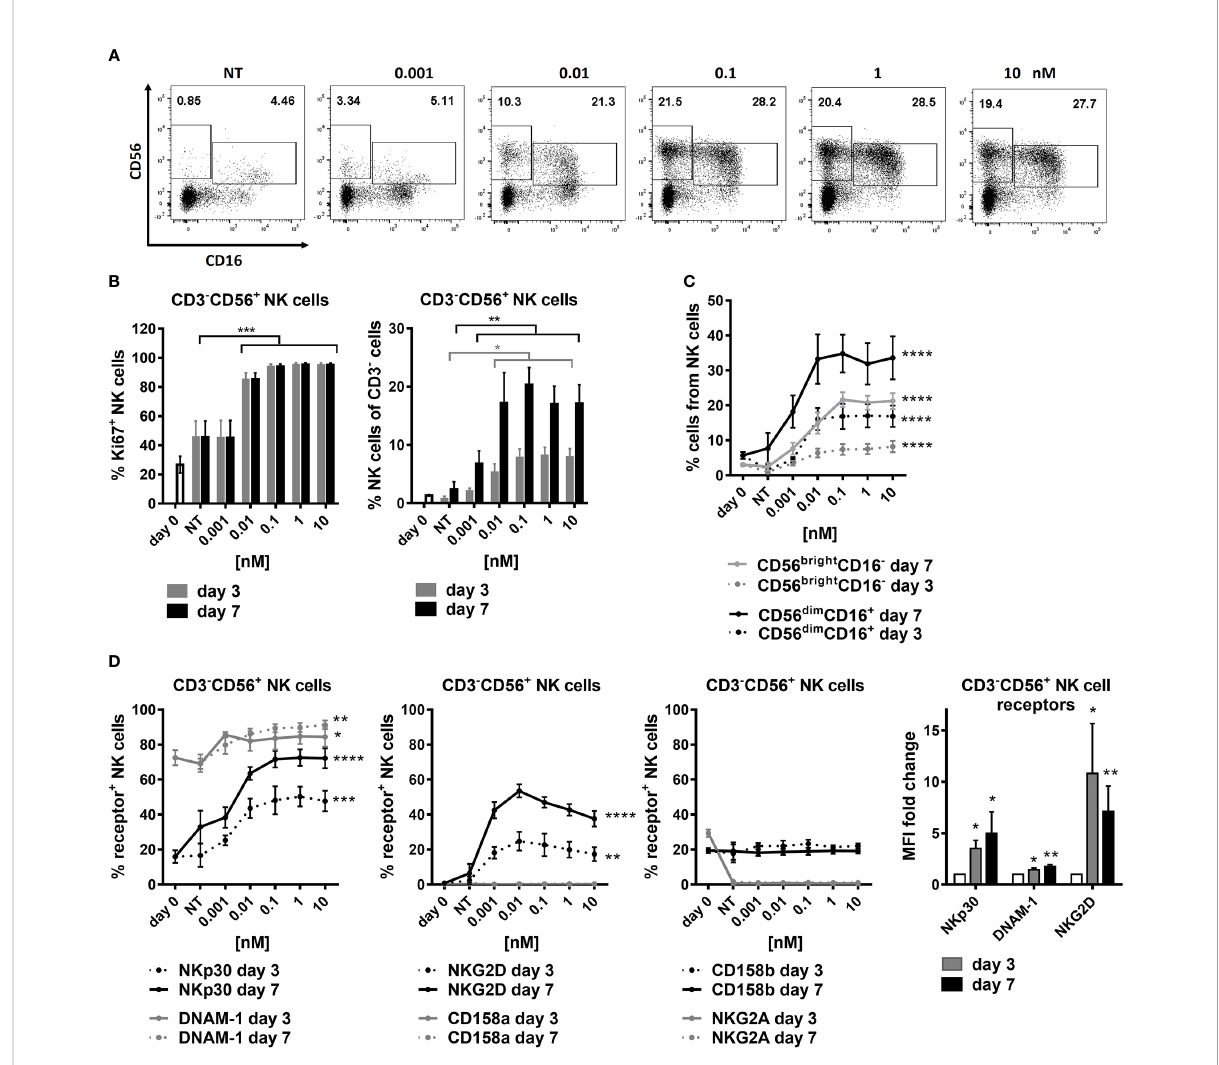
FIGURE 1 SOT101 expands and activates human NK cell subtypes in vitro. Human PBMCs were incubated with the increasing concentrations of SOT101 at 0.001 – 10 nM for 7 days (NT – non-treated). NK cells (CD3 - CD56 + ) and their subpopulations (CD56 dim CD16 + and CD56 bright CD16 - ) were analyzed by fl ow cytometry at day 3 and 7. (A) representative dotplots from day 7 are shown (B) SOT101-stimulated proliferation and the relative expansion human NK cells and (C) their subpopulations CD56 dim CD16 + and CD56 bright CD16 - in a concentration-dependent manner already at day 3 in vitro . Statistical signi fi cance from SOT101 at 0.01 nM. NK cell proliferation was detected as a percentage of Ki67 + cells. (D) SOT101 increased the relative number of NK cells expressing the activating receptors DNAM-1, NKp30, and at low concentrations also NKG2D, and increased their expression on NK cells (fold change of MFI with SOT101 at 1 nM) already at day 3. Statistical signi fi cance from SOT101 at 0.01 nM for NKp30, DNAM-1 and from SOT101 at 0.001 nM for NKG2D. SOT101 did not change the expression levels of the inhibitory receptors NKG2A, CD158a and CD158b on NK cells. Data represent mean ± SEM from 4-8 healthy donors. The results were considered statistically signi fi cant if * p < 0.05, ** p < 0.01, *** p < 0.001 or **** p <